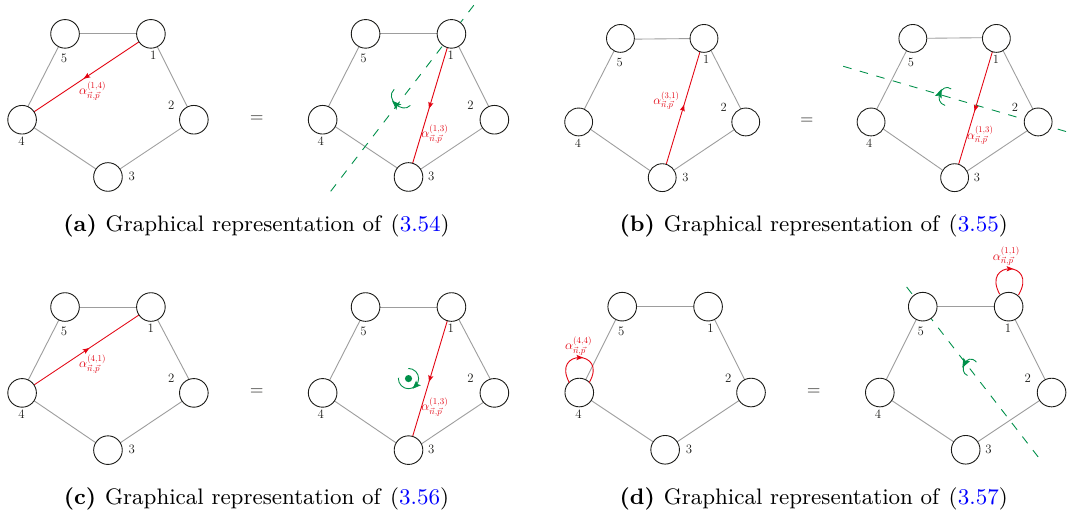
Figure 2. A graphical representation for the symmetries between Gram-Schmidt coefficients α